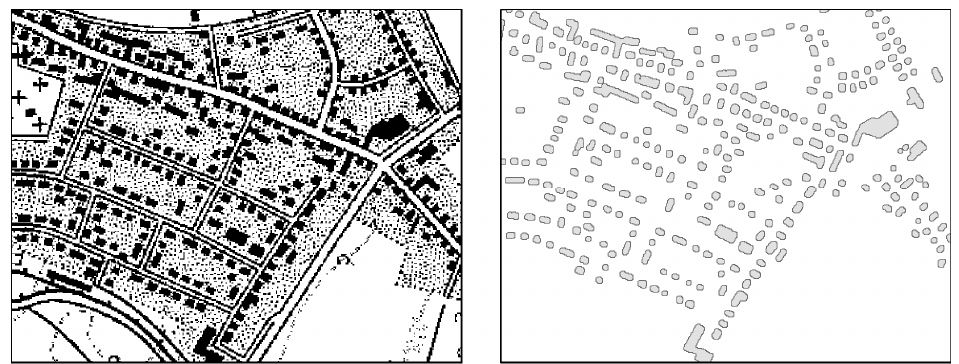
Figure 2. Original binarized map images (left, black–foreground, white–background) and the retrieved building footprints (TK25 © LVermGeo 2014).